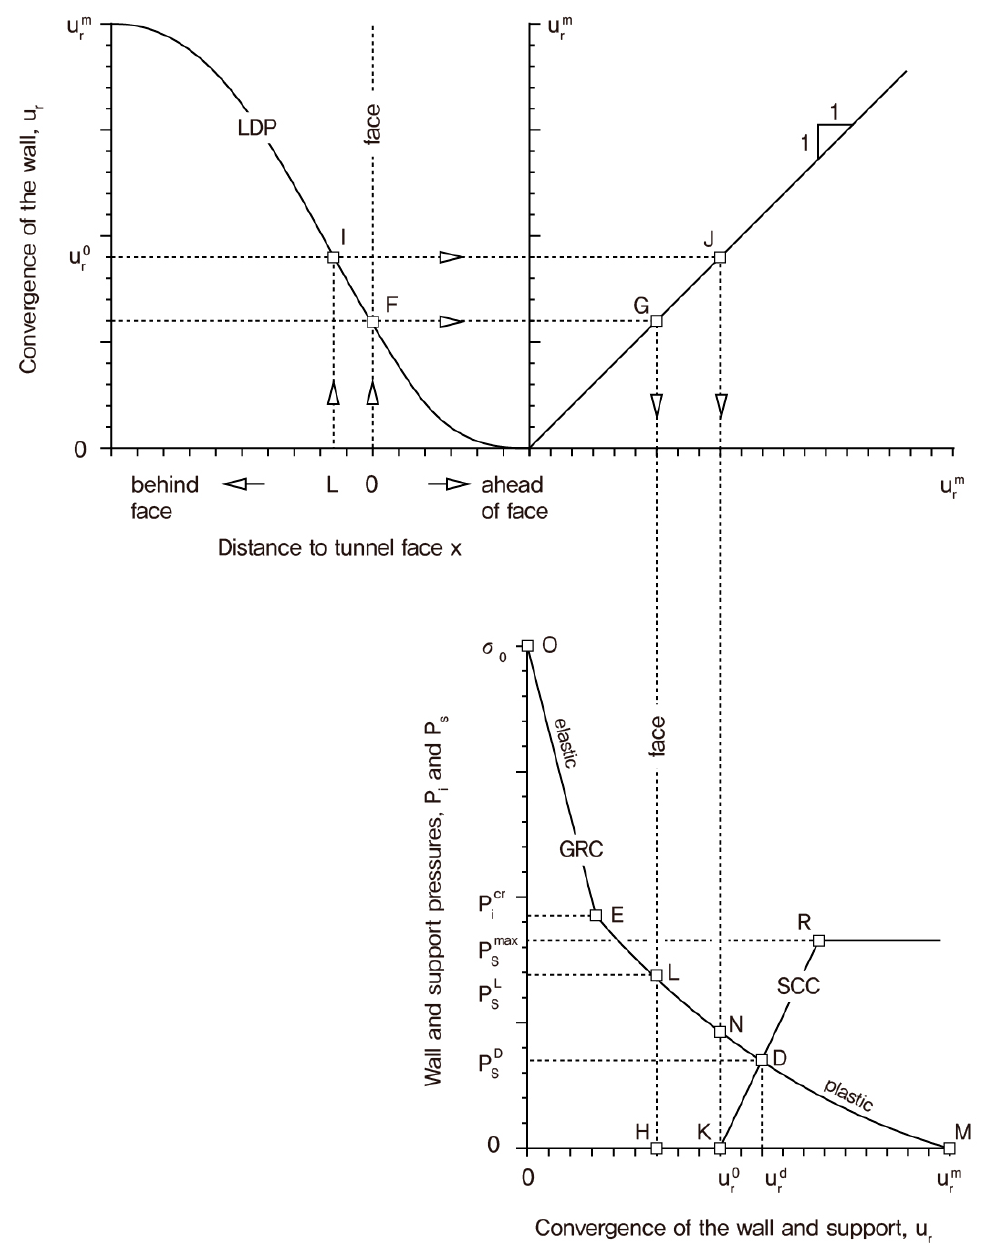
Figure 1. Schematic of the longitudinal deformation profile (LDP), ground reaction curve (GRC), and support characteristic curve (SCC) [1].